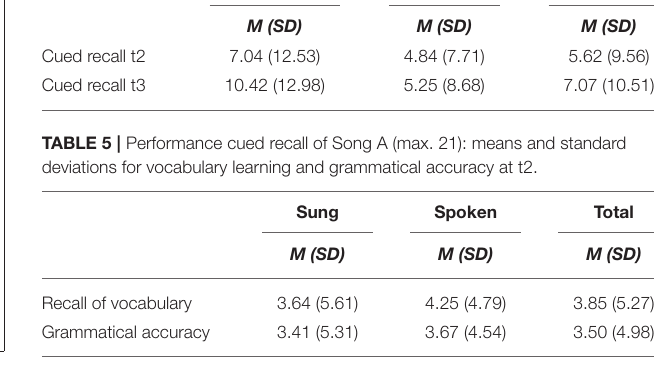
TABLE 6 | Performance cued recall of Song B (max. 36): means and standard deviations for vocabulary learning and grammatical accuracy at t2. Sung